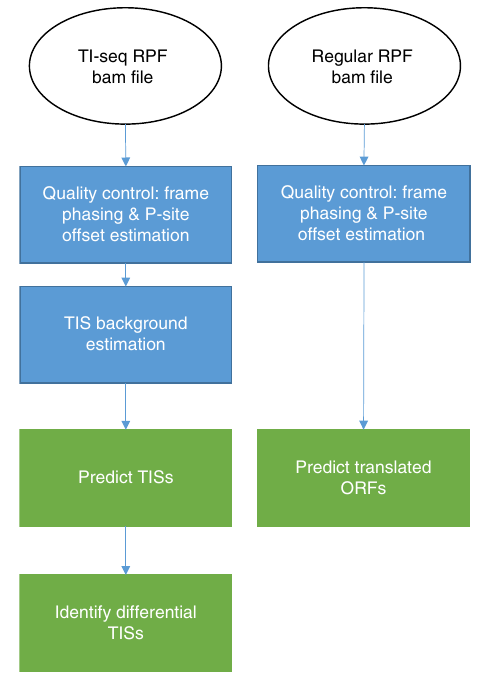
Fig. 1 A schematic overview of Ribo-TISH. Ribo-TISH starts from quality control of the aligned sequencing data to identifying and differential analysis of translation initiations from TI-seq/QTI-seq data, and to predicting actively translated ORFs from rRibo-seq